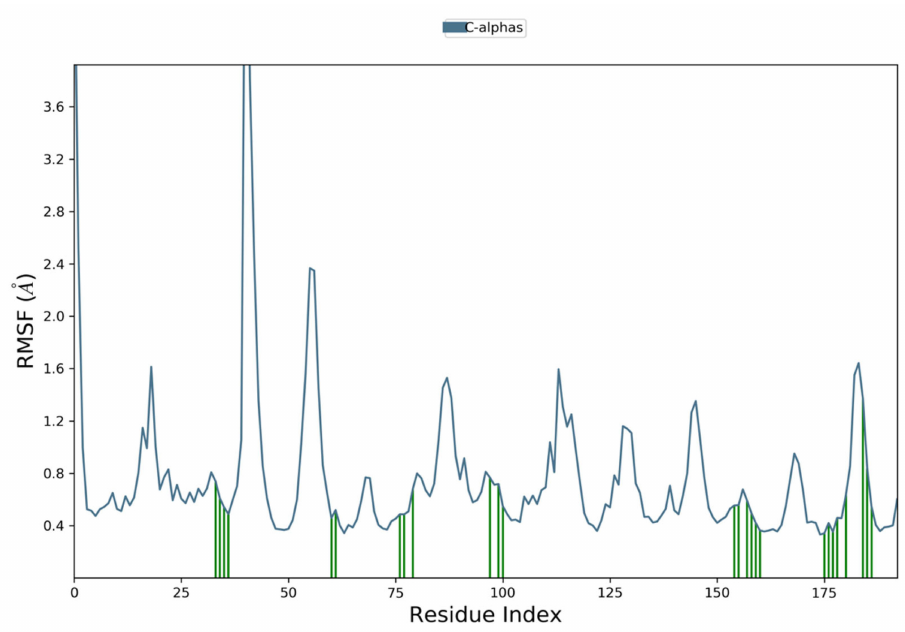
Figure 11. Root Mean Square Fluctuation plot NS2B-NS3 complex of ZIKV PDB ID: